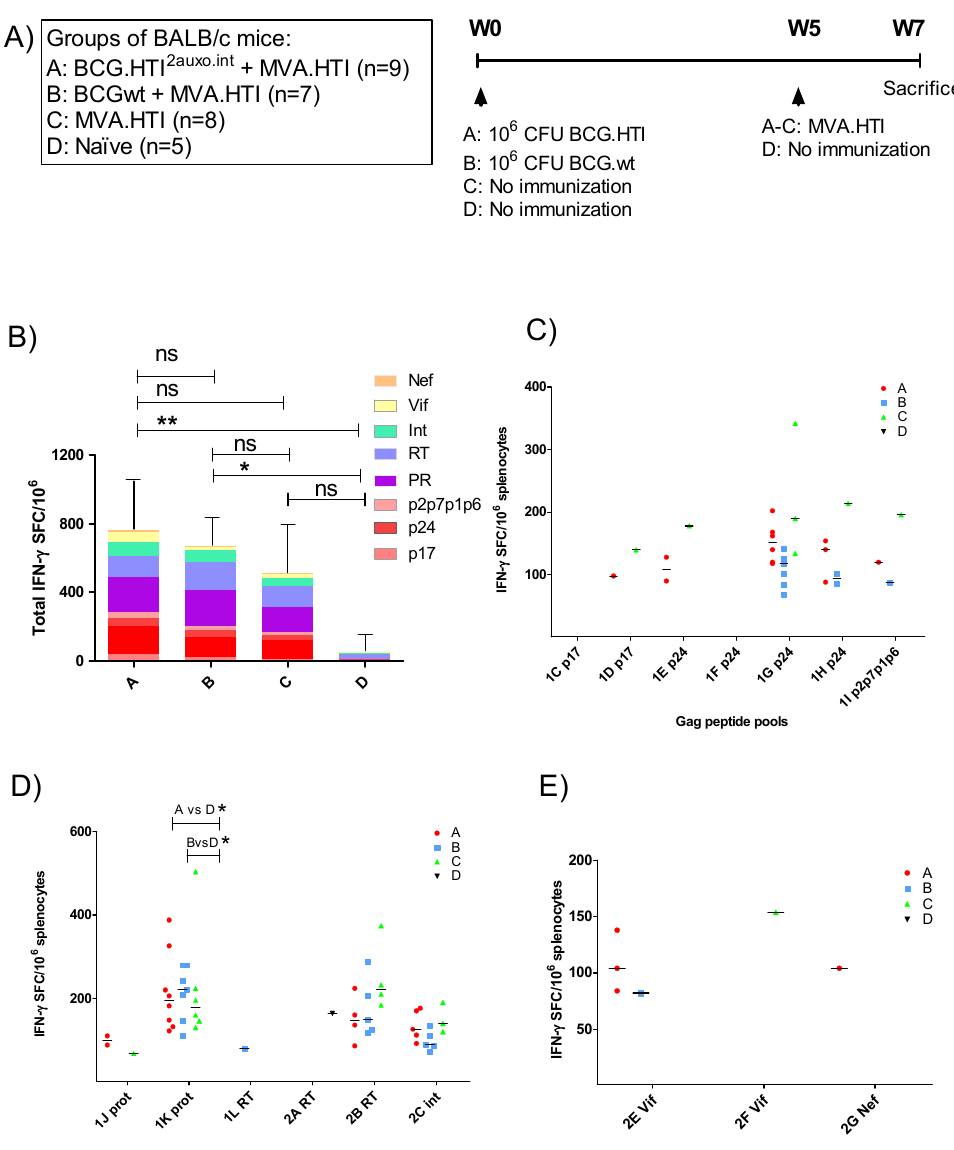
Figure 2. Induction of HIV-1 specific T-cell responses by the BCG.HTI 2auxo.int + modified vaccinia AnkaravirusHIVACATT-cellimmunogen(MVA.HTI)prime-boostregimeninBALB / cmice. ( A )Groups and the immunization schedule. Adult mice (seven weeks old, n = 5–9 / group) were immunized with either 10 6 cfu of BCG.HTI 2auxo.int (intradermally) and boosted with MVA.HTI (10 6 pfu, intramuscular) after five weeks (group A), or with 10 6 CFU BCGwt (id) and boosted with MVA.HTI (10 6 pfu, intramuscular) after five weeks (group B), or only immunized with MVA.HTI (10 6 pfu, intramuscular) at week five (group C), or left unimmunized (group D). Two weeks post-boost, mice were sacrificed, and splenocytes were isolated for enzyme-linked immune absorbent spot (ELISpot) analysis. ( B ) The total magnitude of HIV-1 specific SFCs / 10 6 splenocytes was calculated as sums of the SFCs elicited by the 17 HTI peptide pools, the color-coding represents the HIV-1 gene location of the pools. Data are presented as group means and error bars represent the standard deviation of the total sum of SFC / 10 6 splenocytes. Statistics were performed using the non-parametric Kruskal–Wallis test adjusted for multiple comparisons, * p < 0.05, ** p < 0.01 ( C – E ). HIV-1-specific T-cell responses interferon- γ (IFN- γ spot-forming cells SFC / 10 6 in response to HTI-derived peptide pools representing HIV-1 gag ( C ), HIV-1 pol ( D ), and nef + vif ( E ). The data are presented as medians of group responses above the threshold. ns: not